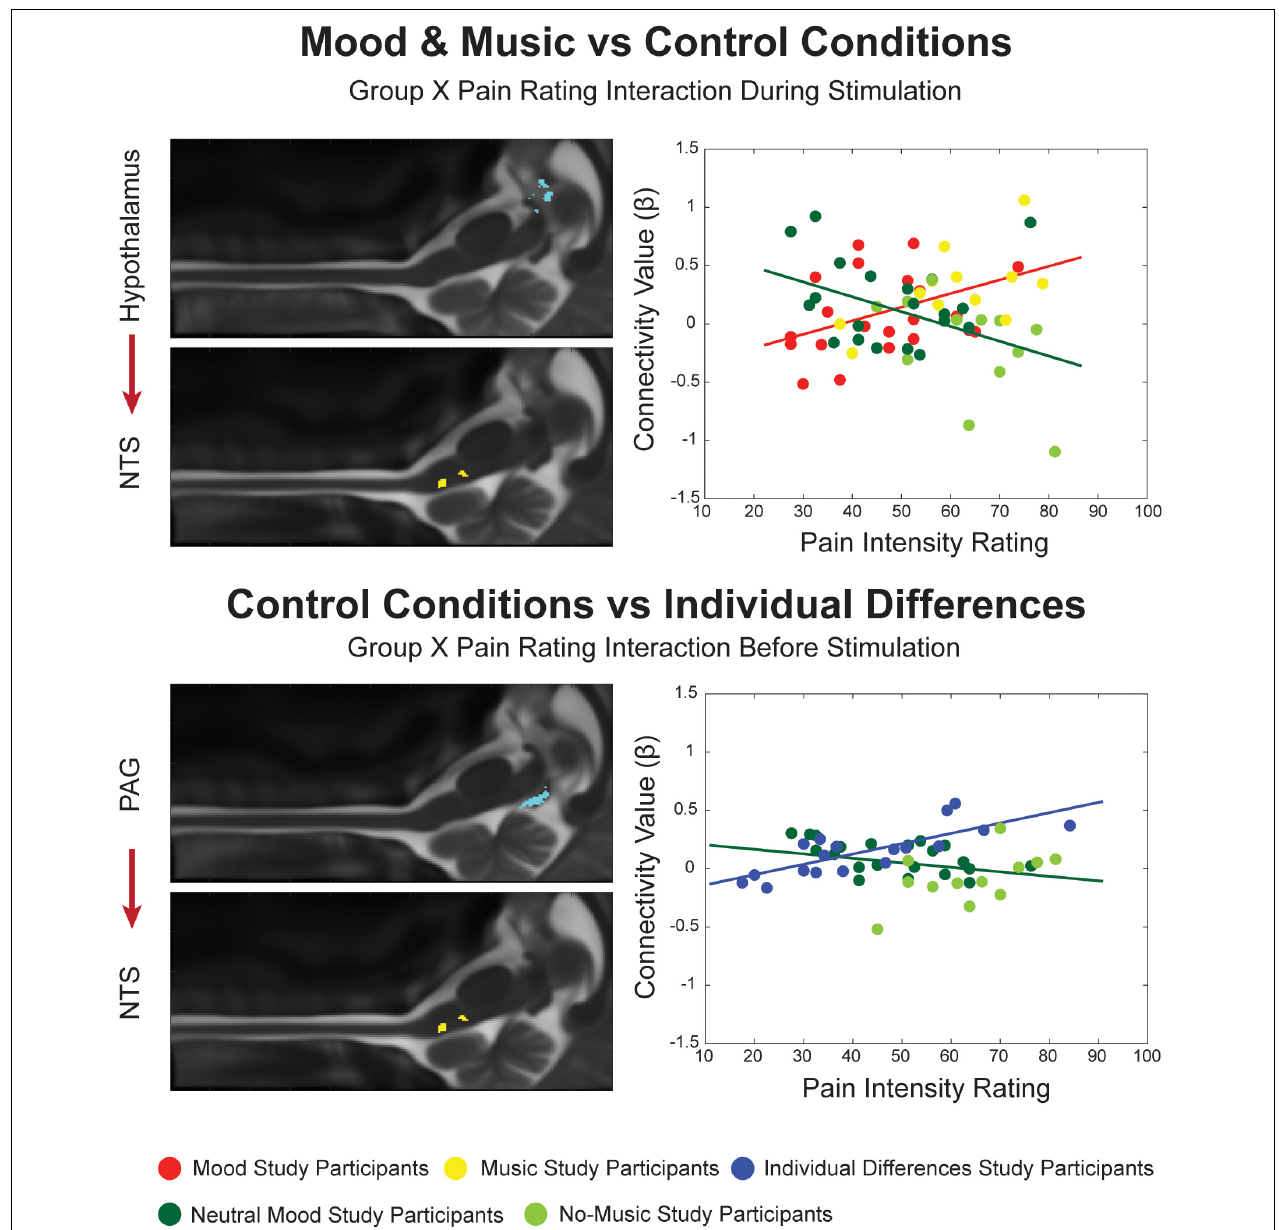
FIGURE 4 | Significant Group X Pain Rating ANCOVA results for the Mood and Music condition, their combined Control conditions and Individual Differences. Regions are highlighted and labeled on sagittal slices of the anatomy (left) . The figure legend refers to the plotted results of the ANCOVA (right) with red and yellow points representing Mood and Music study participants, respectively, corresponding to the red trendline as a combined group. The blue points and trendline represent the separate Individual Differences condition. The Neutral Mood and No-Music conditions are represented as dark and light green, respectively, corresponding to the dark green trendline as the combined control